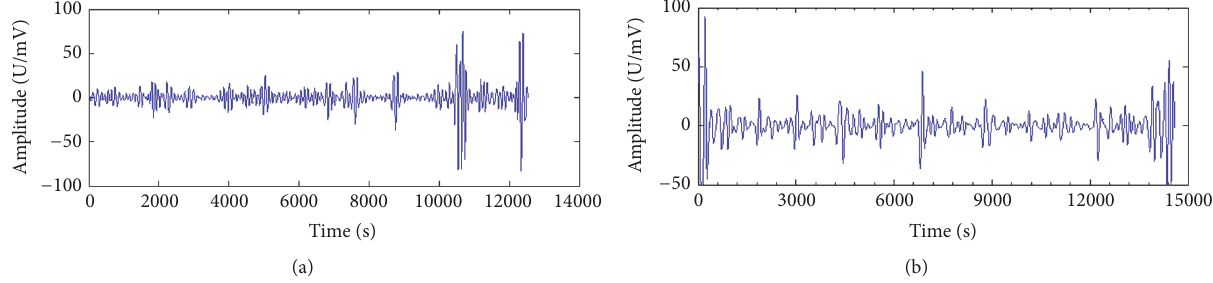
Figure 4: Brain waves belonging to alpha (𝛼) and theta (𝜃) .